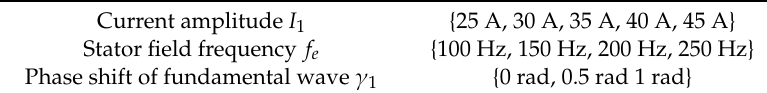
Table 3. Parameter combination possibilities of the examined operating points for validation of the analytical calculation method of the reluctance torque for IPMSM.